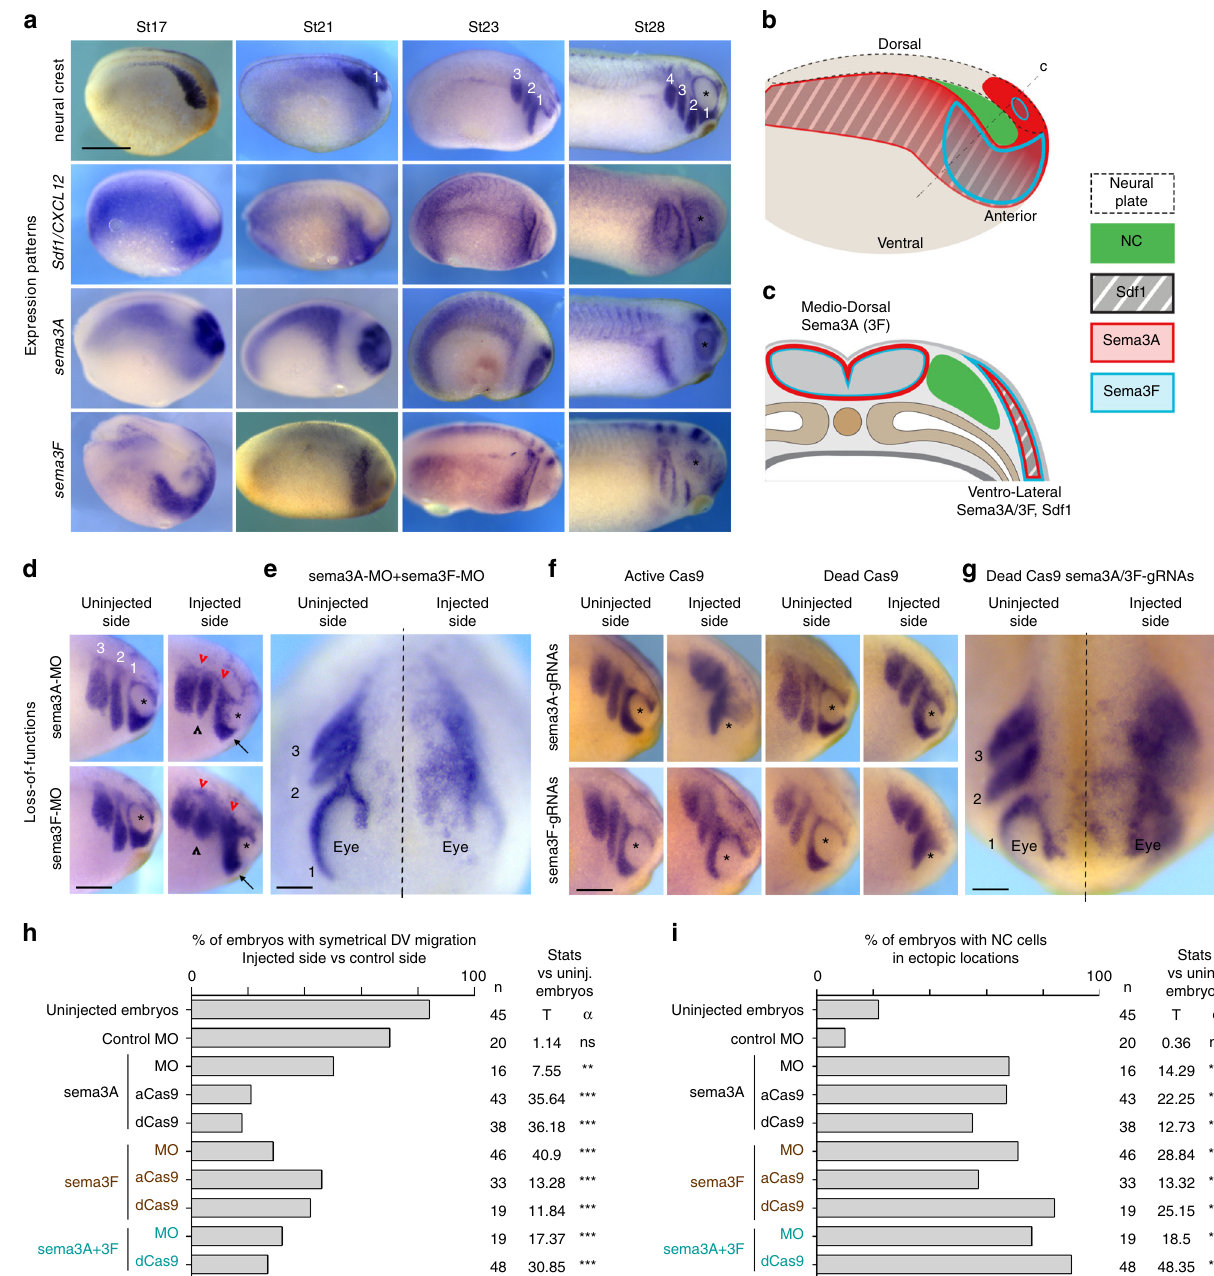
led to signi fi cant increases in embryos with asymmetrical left- right NC migration (Fig. 1h) and embryos with NC cells in ectopic locations (Fig. 1i). To further ensure that NC identity was not affected by the CRISPR/Cas9 treatments, we performed in situ hybridisation against Slug and found no downregulation (Supplementary Fig. 2). To obtain a dynamic view of how cells migrate in control and semaphorin knockdown (sema-KD) environments in vivo, we performed time-lapse imaging of NC migration (Fig. 2, Supplementary Movie 1). We grafted fl uor- escent control NC cells into control embryos or embryos injected with sema3A-MO or sema3A gRNAs with aCas9 or dCas9 (Fig. 2a). Embryos were monitored from 4 h after grafting. When control NC are grafted into control embryos the fi rst stream of cells is already starting to migrate along the eye after 4 h (Fig. 2b, arrowhead) whereas in the sema-KD conditions it has